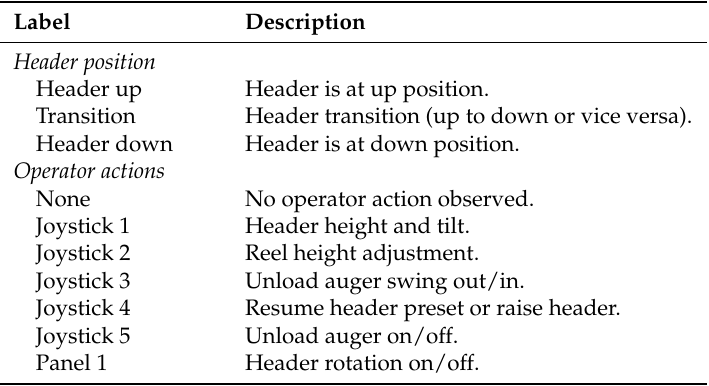
Table 7. Header position and operator action contextual labels.